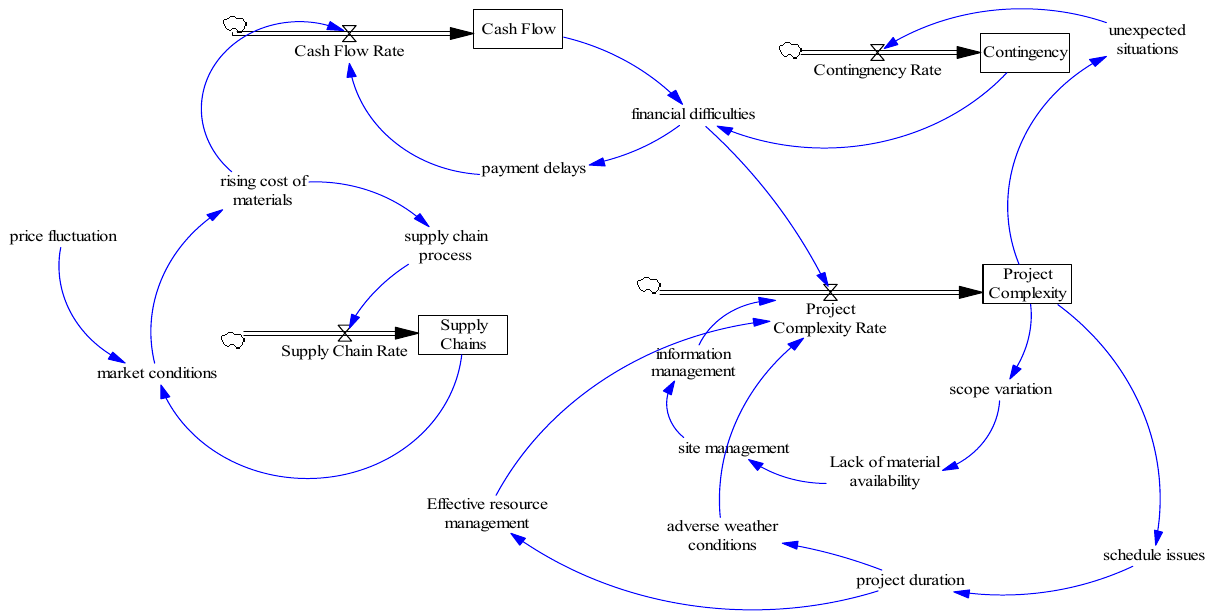
Figure 9. System dynamic modeling.